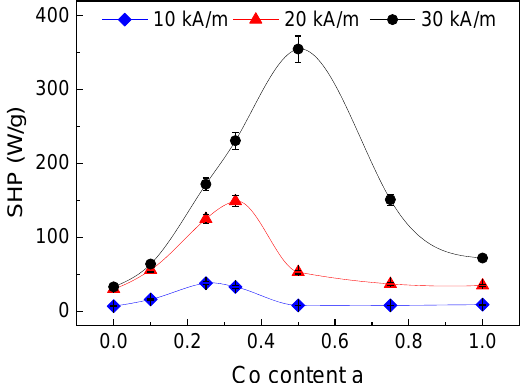
Figure 8. SHP of the immobilized particles for three different field strengths (10, 20, and 30 kA/m); the lines serve as a guide to the eye only, for some data points error bars are within the symbols.